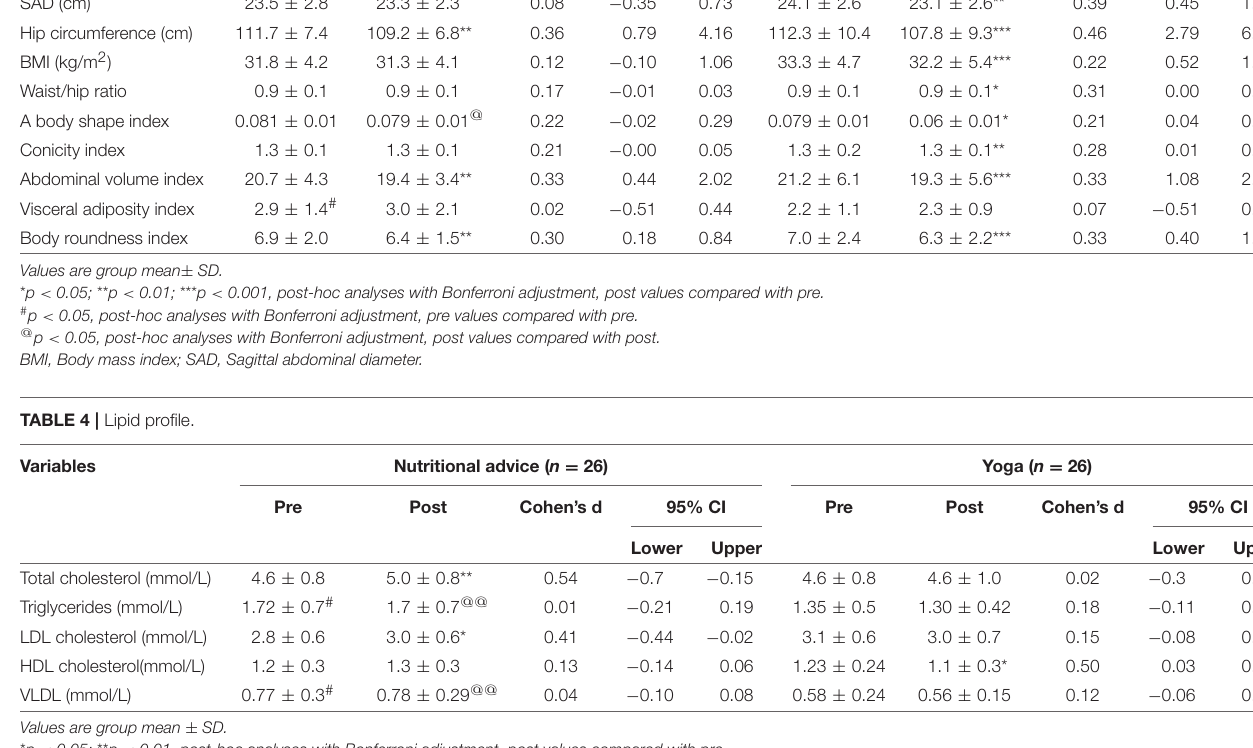
TABLE 3 | Anthropometric variables. Variables Nutritional advice ( n = 26) Yoga ( n = 26) Pre Post Cohen’s d 95% CI Post Cohen’s d Lower Upper Lower Upper Waist circumference (cm)